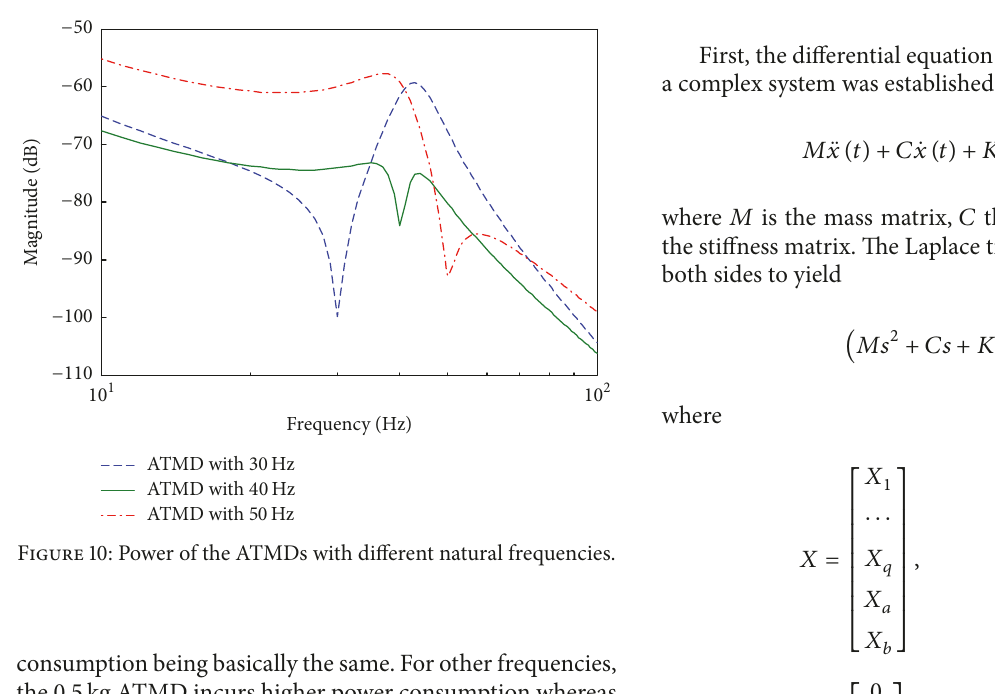
consumption being basically the same. For other frequencies,